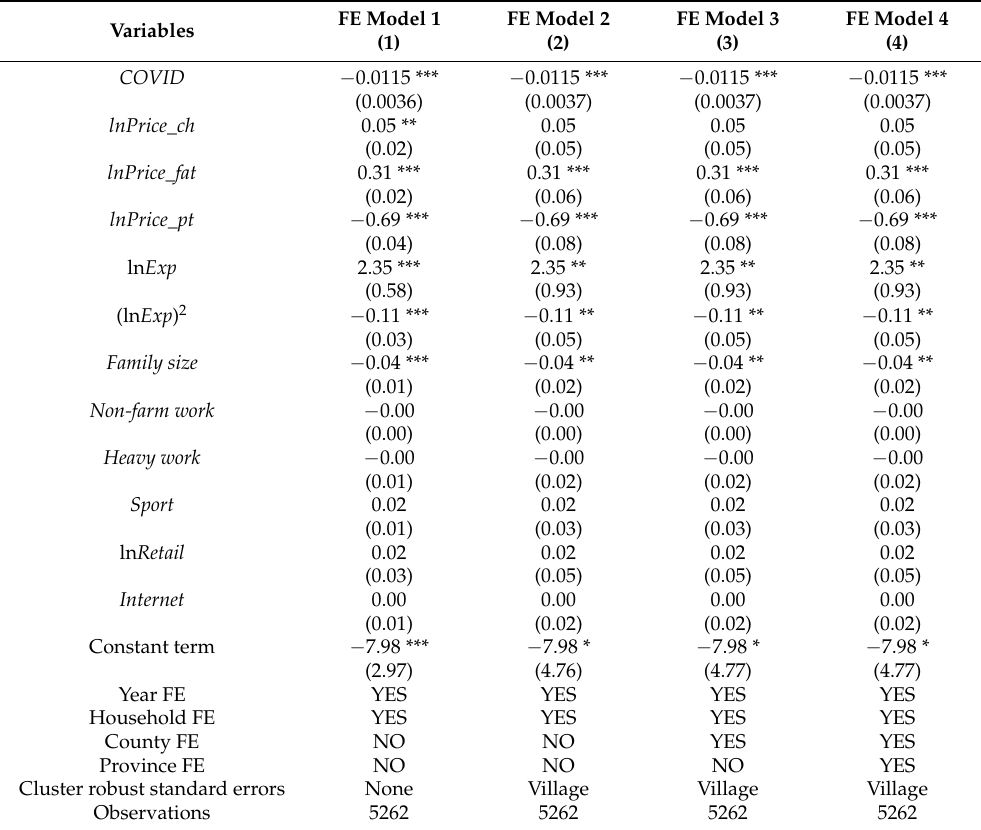
Table 6. Estimation results of the COVID-19 impact on protein